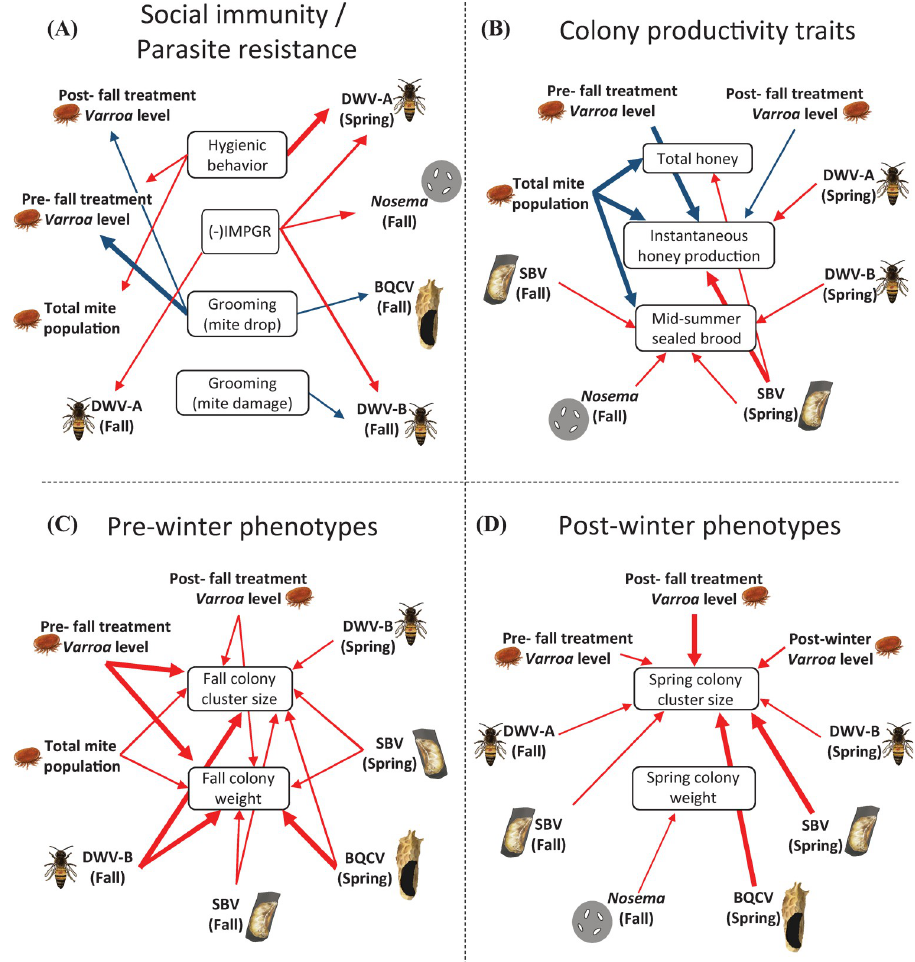
Fig 4. Graphical representation of linear regressions of colony phenotypes and pathogens. Arrows represent the effect of social immunity behaviors / parasite resistance (central boxes) on pathogen and parasite loads (A), the effect of pathogens and parasites on colony productivity traits (B), or the effects of pathogens and parasites on pre-winter (C) and post-winter (D) colony phenotypes. Positive relationships are illustrated with blue arrows and negative relationships with red arrows. Thicker arrows represent relationships that were observed in both experimental years, while thin arrows indicate that relationships observed only in one of the two experimental years. Only statistically significant relationships are shown. Refer to Table 4 for estimates of coefficients and statistical